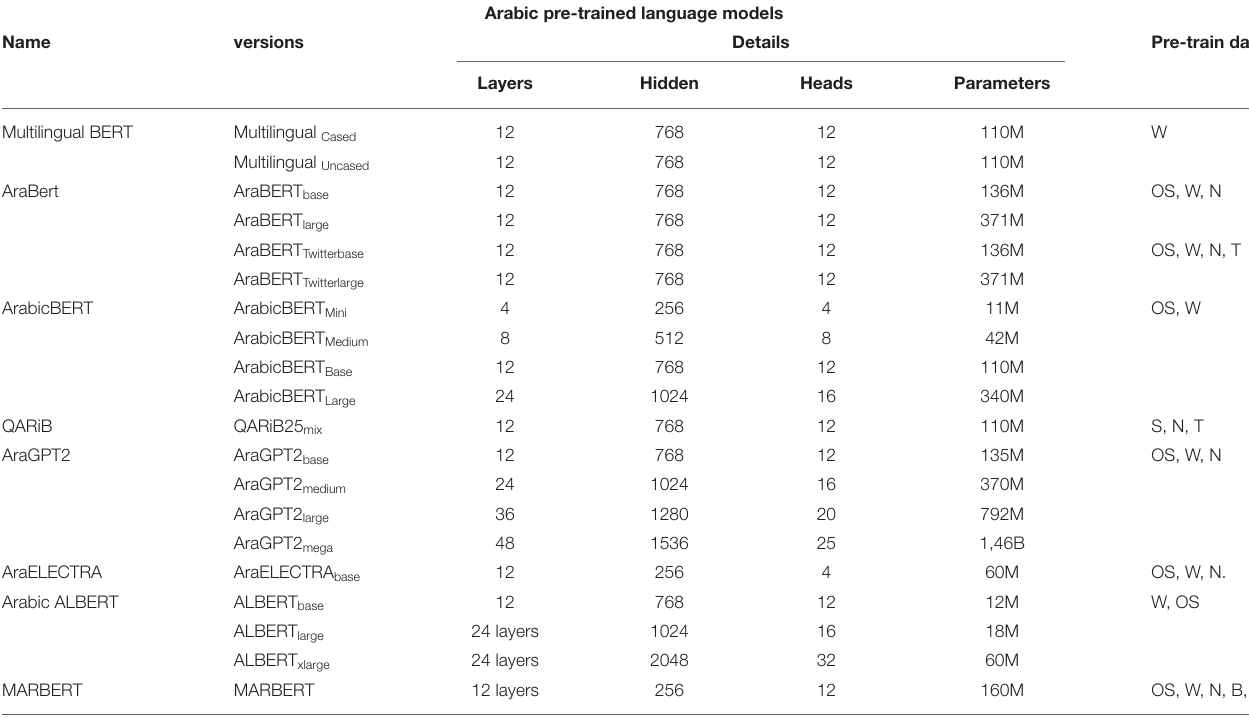
TABLE 1 | Summary of Arabic pre-trained language model versions, architecture details, and training data sets. Arabic pre-trained language